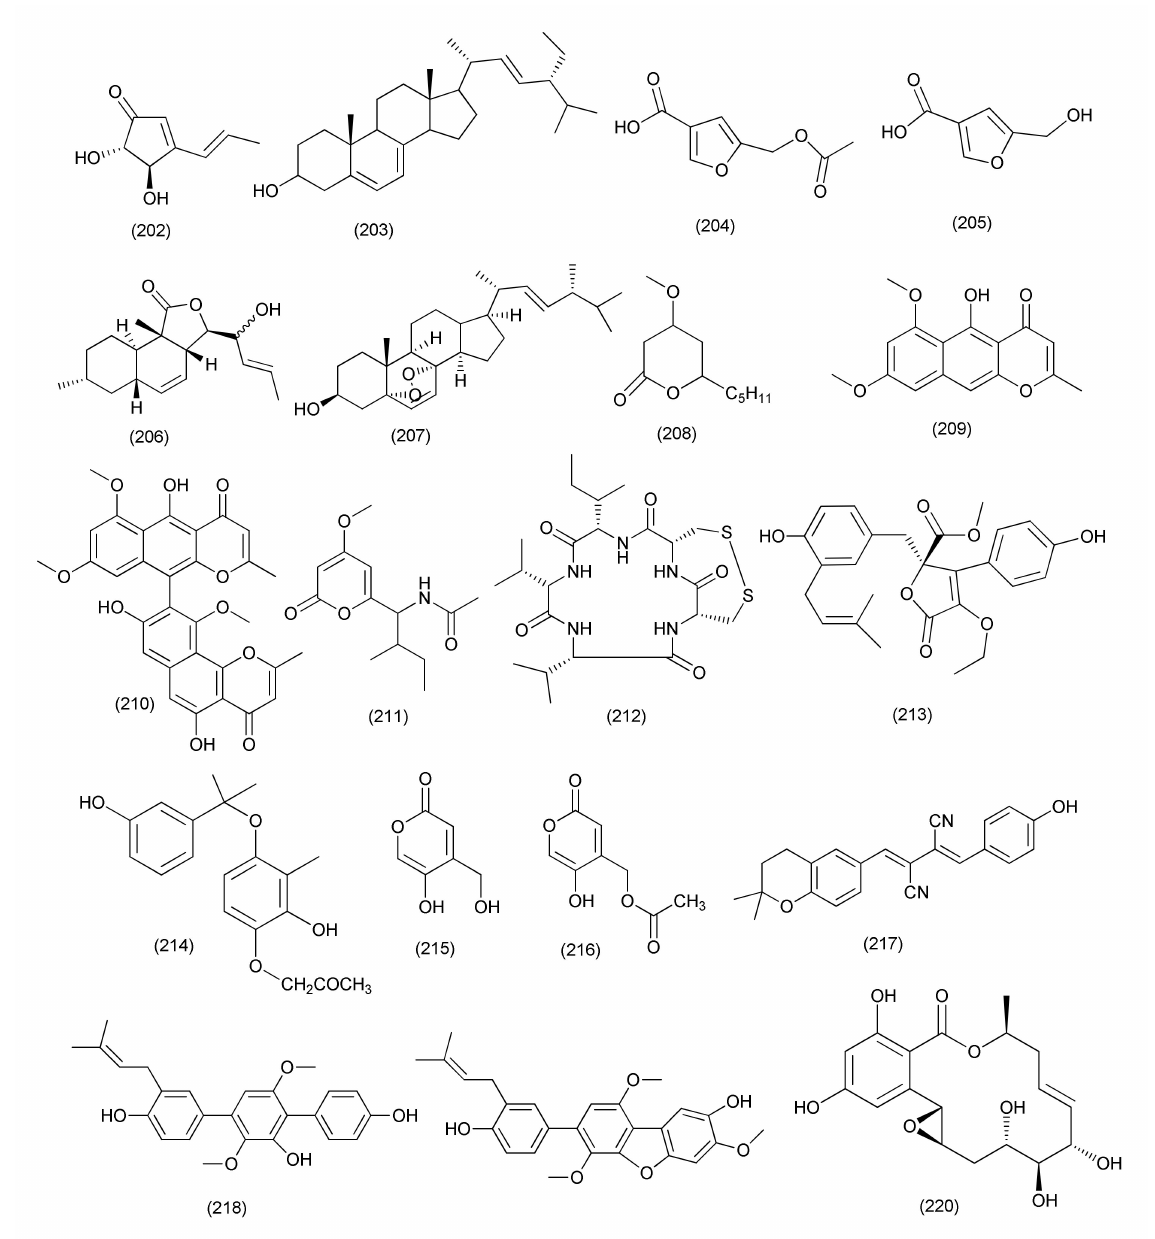
Figure 12. Structures of metabolites 202 – 220 isolated from Anamorphic